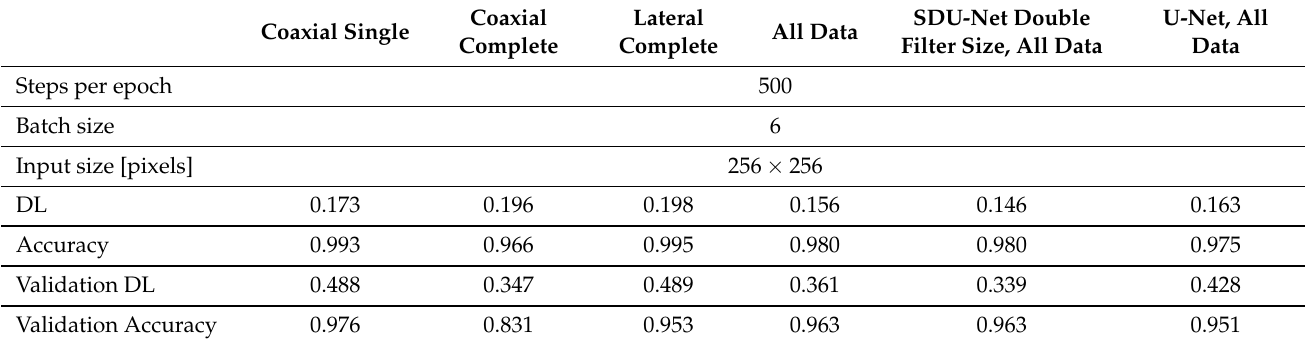
Table 1. Training results of the neural network models based on the SDU-Net architecture. Three different models are trained for each input data generation approach. The fourth model was trained for the prediction of all data. In comparison the results of an SDU-Net architecture with twice the number of filters and of the small U-Net are